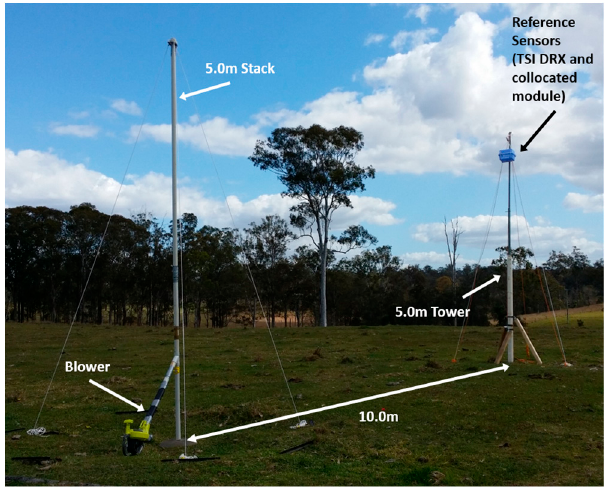
Figure 13. Experimental set up for the flight tests with the source stack and the monitoring tower.